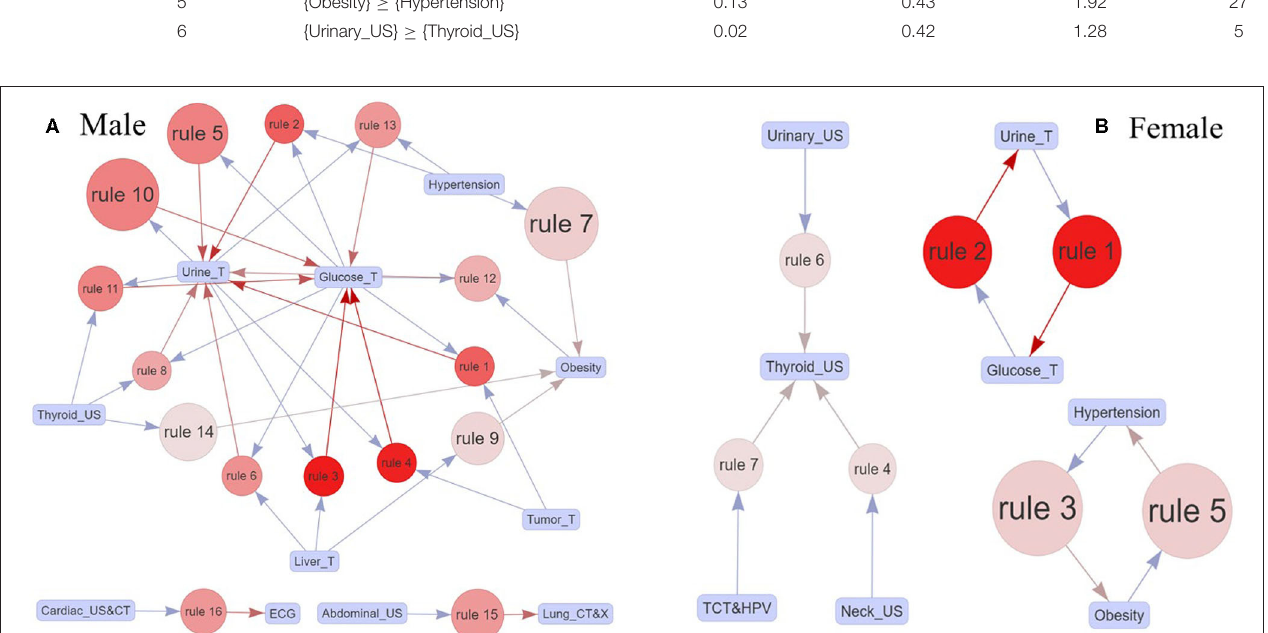
FIGURE 4 | (A,B) The effective association rules for the male and the female participants. A rule was composed of boxes, arrows, and a circle; the blue and red arrows were the critical values on LHS and RHS; and the size and the color of the circle showed the support of the critical value on LHS and the lift of the rule, respectively.